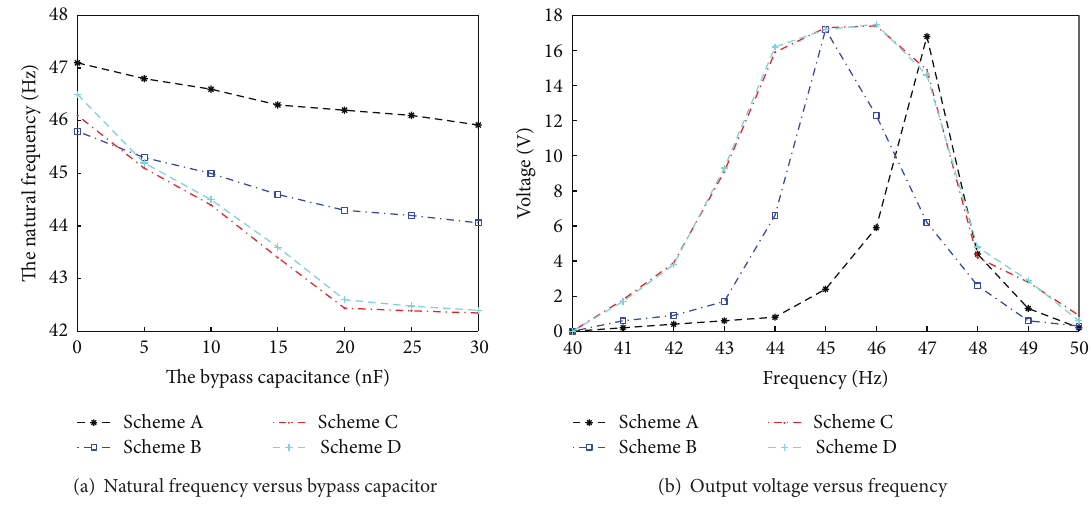
Figure 10: Experimental results of capacitance FM